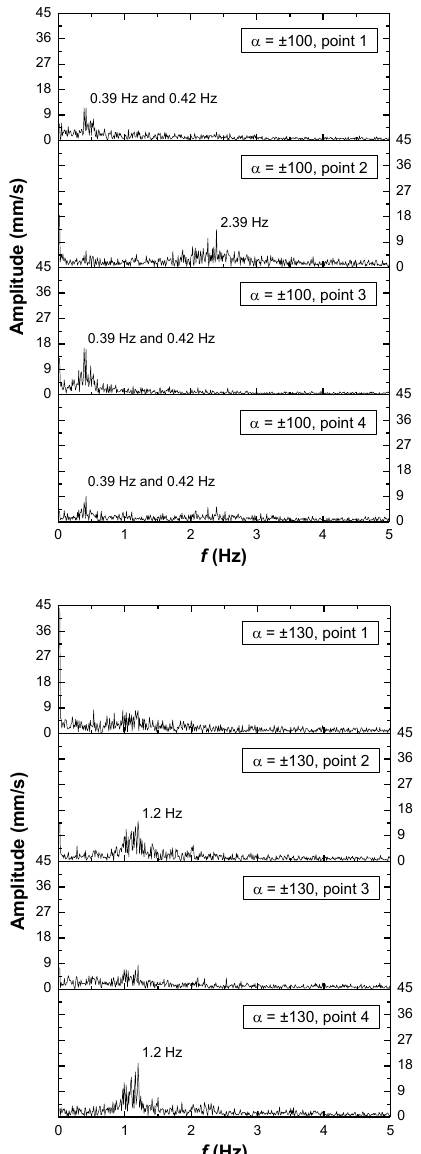
Fig. 9. Power spectra of the transverse velocity – time history at four